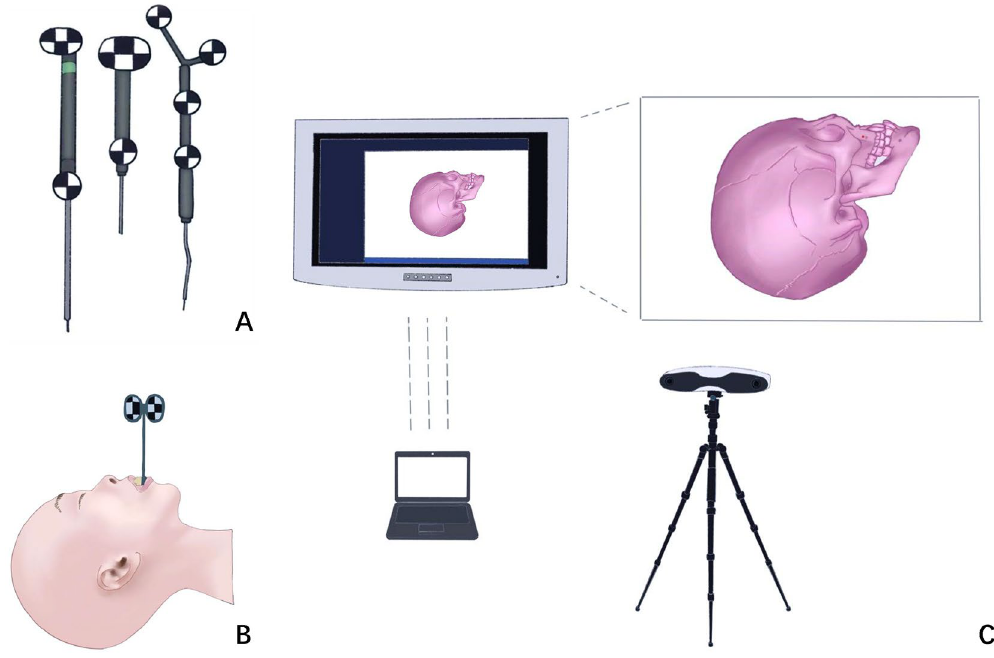
Figure 3. Compositions of OSNS